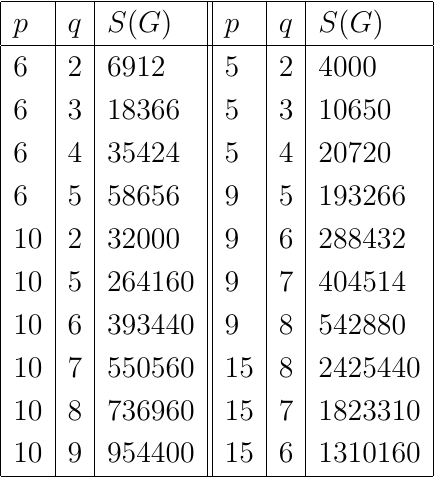
Table 1. Schultz index of short tubes, p > q .